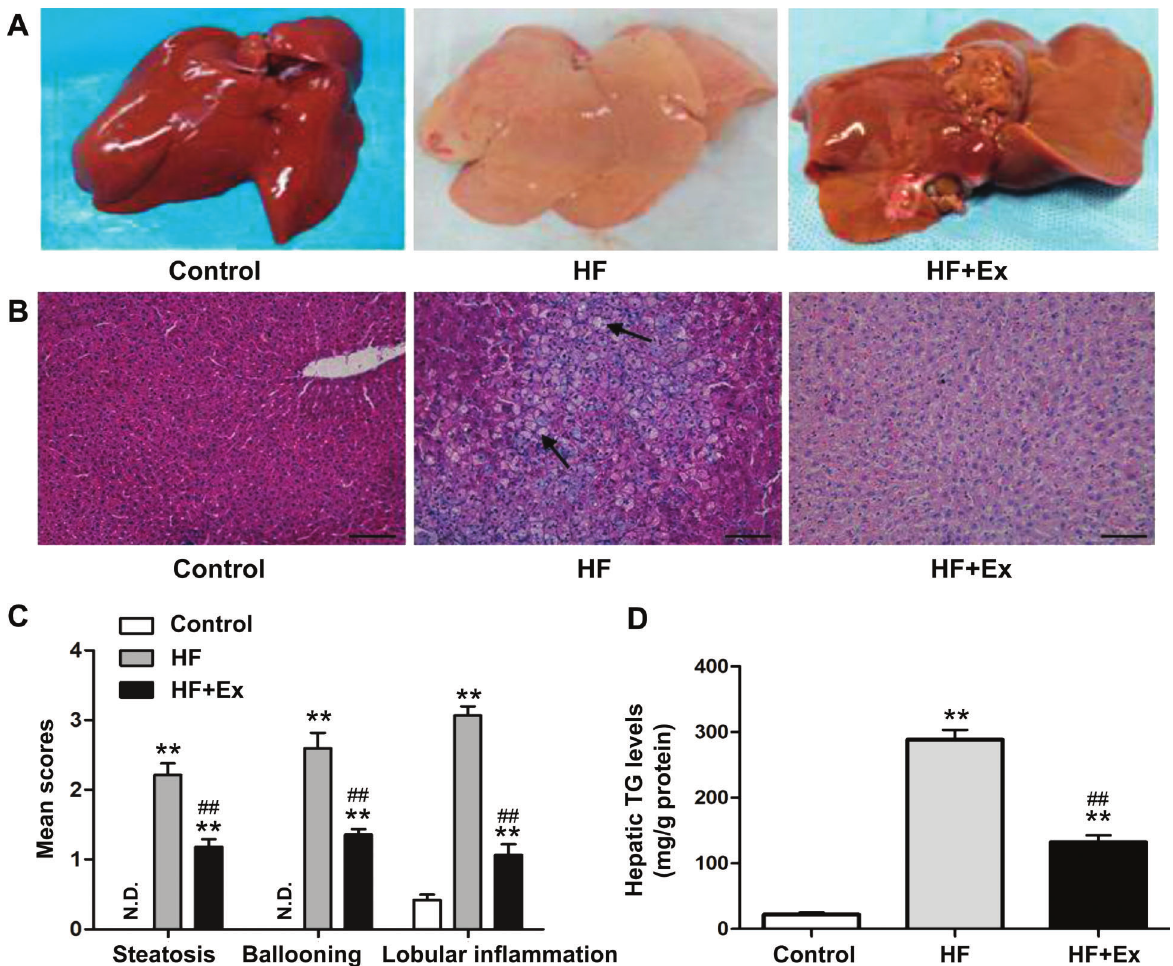
Figure 3. Histopathology of each group. A , Liver specimens from rabbits in each group are shown. B , Liver sections with hematoxylin and eosin (H&E) staining. Arrows indicate lipid droplets. The original magni fi cation was (cid:3) 200. Scale bars=500 m m. C , Non-alcoholic fatty liver disease activity scores were evaluated semi-quantitatively: steatosis (0 – 3), lobular in fl ammation (0 – 2), and hepatocellular ballooning (0 – 2). N.D., not detected. D , Hepatic triglycerides (TG) were extracted from frozen tissue and measured by enzymatic assays. Values of TG were normalized relative to protein concentration. Data are reported as means ± SD (n=8). **P o 0.01 compared with the control group; ## P o 0.01 compared with the high fat (HF) group